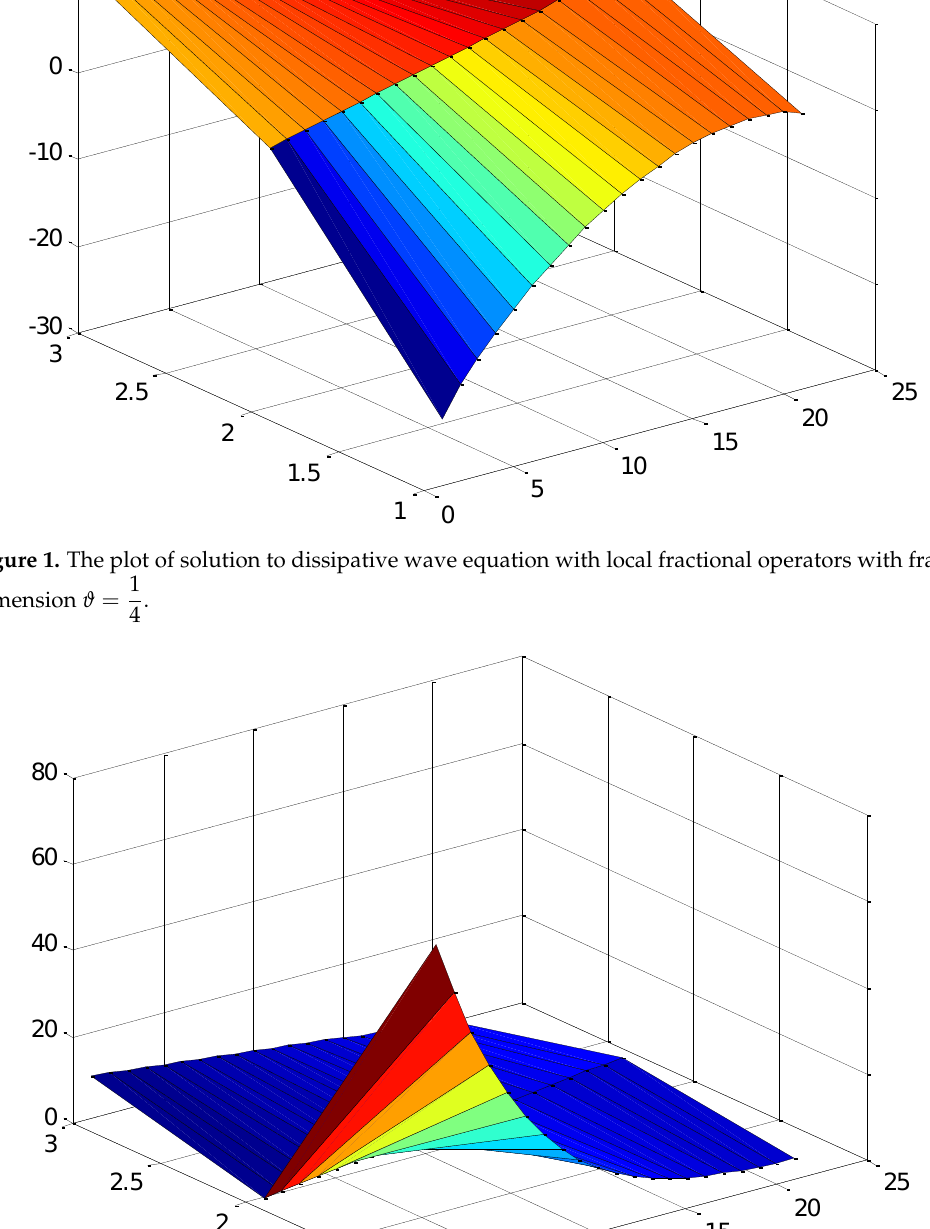
Figure 2. The plot of solution to dissipative wave equation with local fractional operators with fractal ln ( 2 ) dimension ϑ = Figure 2: The plot of solution to dissipative wave equation with local fractional ln ( 3 ) operators with fractal dimension .